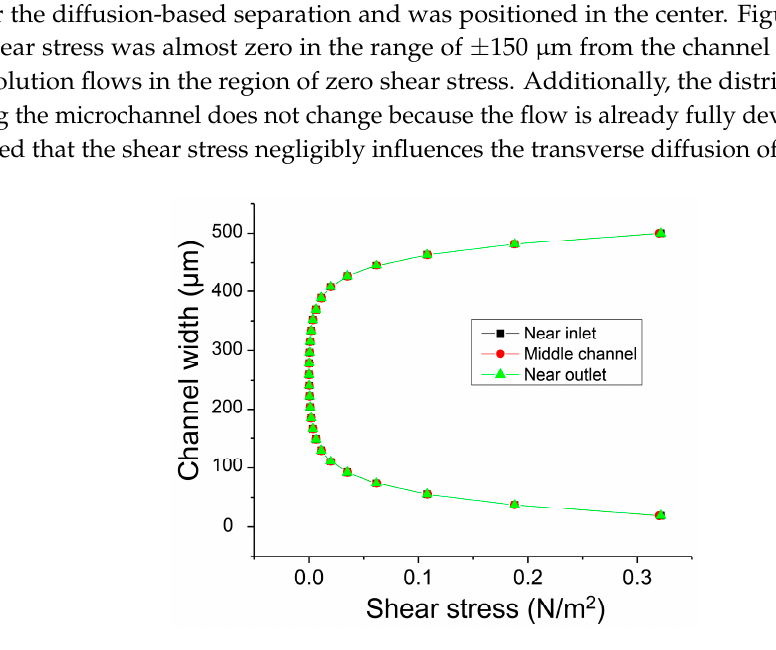
Figure 8. Experimental setup to evaluate the influence of temperature on separation.